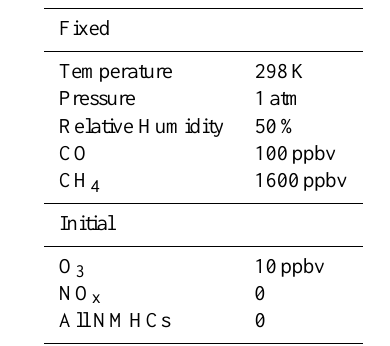
Table 1. Environmental and initial conditions for each simulation scenario.